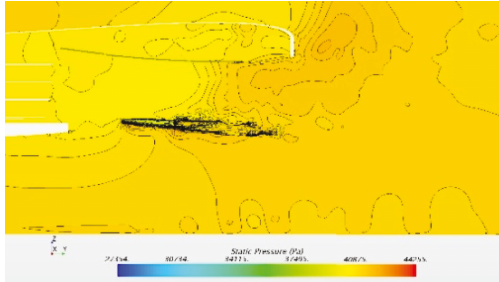
Figure 17: Flow fi eld pressure contour at 0.6s.